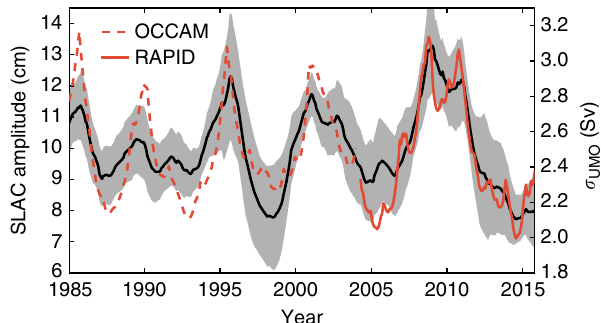
Fig. 9 SLAC from tide-gauge records and the UMO transport. Instantaneous amplitude of the SLAC (left axis) averaged over tide-gauge stations 1 – 10 together with the instantaneous standard deviation of the UMO transport at 26.5°N (right axis) both from RAPID (red solid) and the OCCAM model (red dashed). The gray-shaded area denotes the standard deviation about the average annual amplitude of the 10 tide-gauge